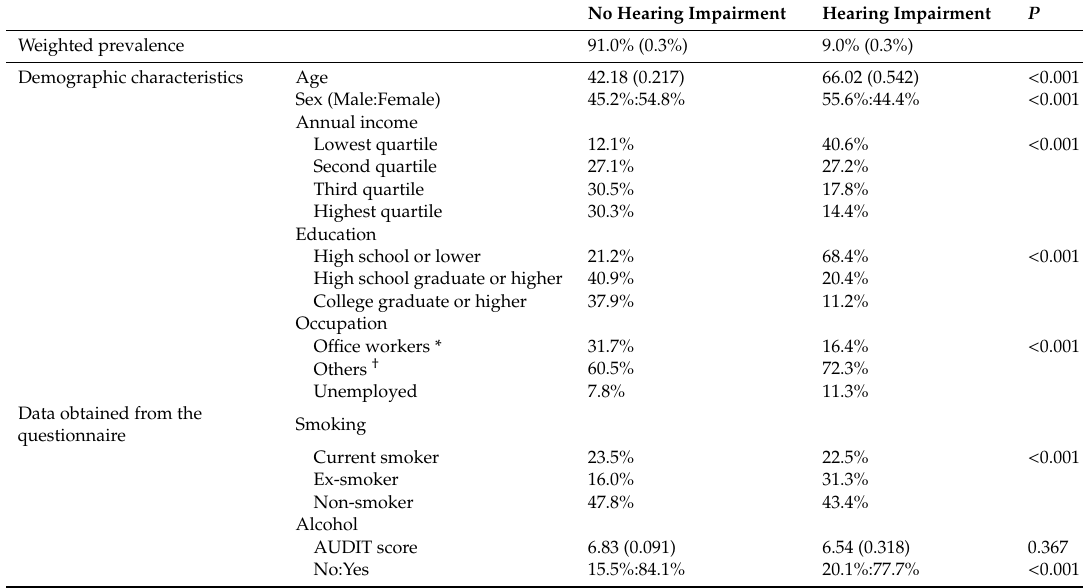
Table 1. Characteristics of the study